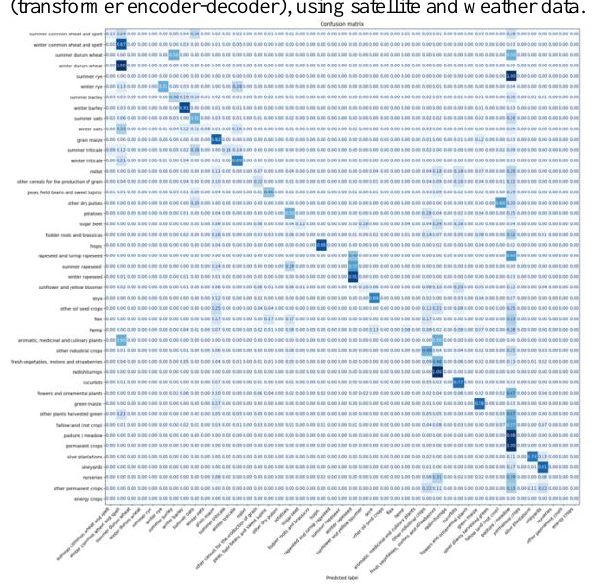
Figure 8. Confusion matrix normalized by target label.